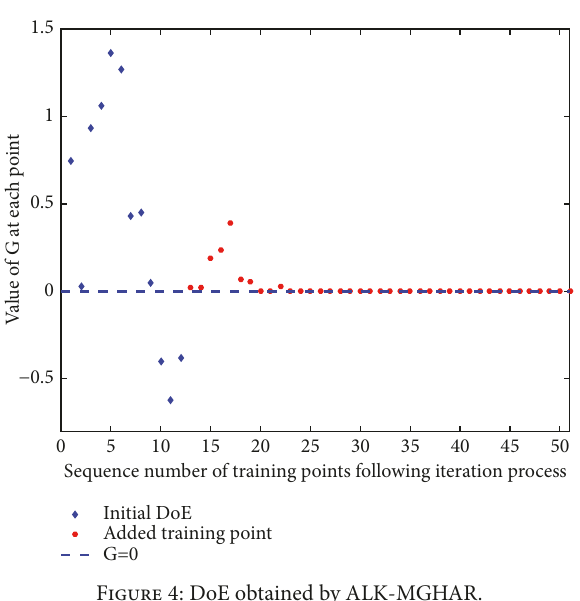
Figure 4: DoE obtained by